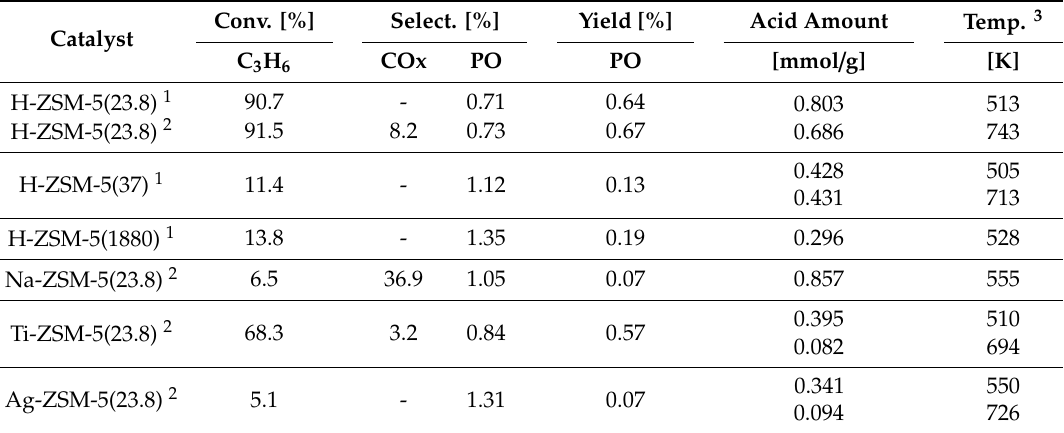
Table 3. Catalytic activities and acid properties on H-ZSM-5 and related